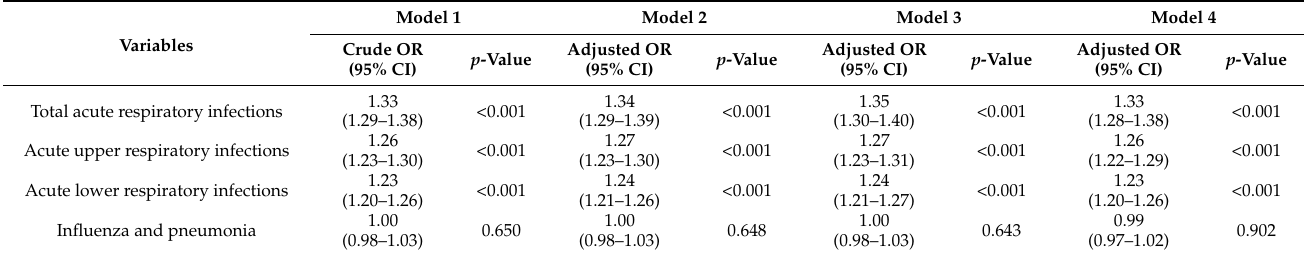
Table 3. ORs and 95% CIs for chronic periodontitis in participants with acute respiratory infections in univariate and multivariate logistic regression